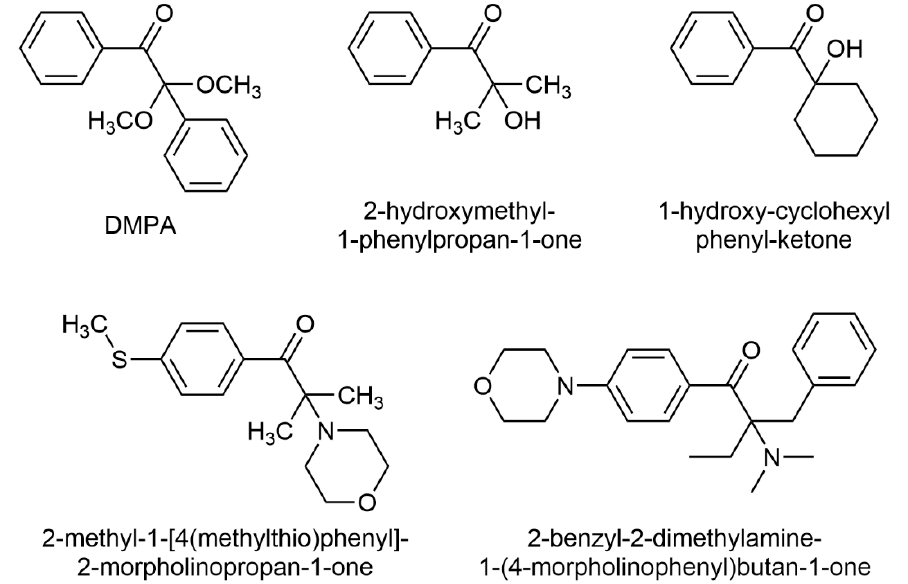
Figure 7. Common type I